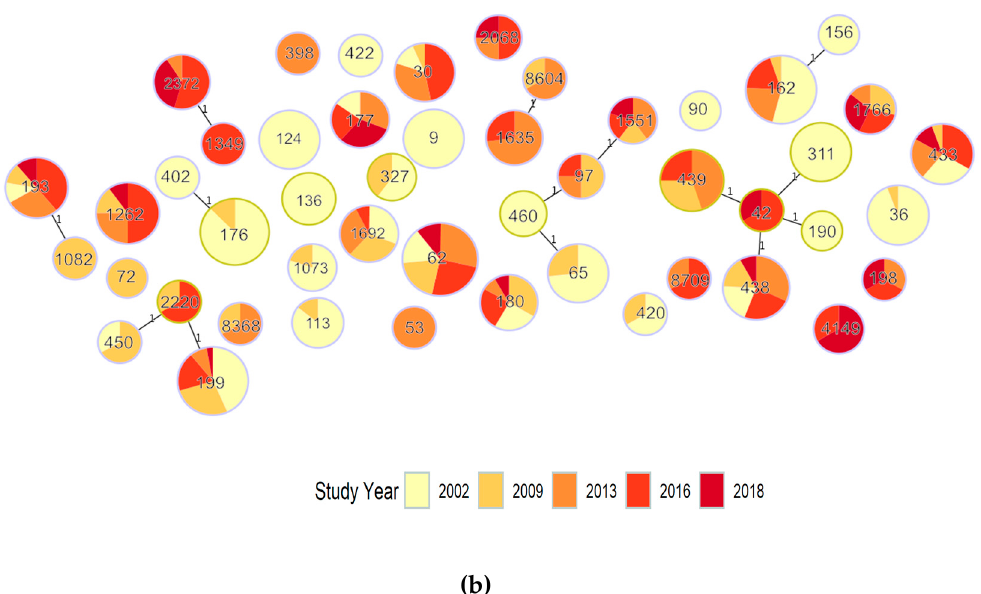
Figure 1. Minimum spanning tree of dominant ST, showing single locus variants and labelled by ST; ( a ) colored by vaccine category for the serotype; ( b ) colored by study year.